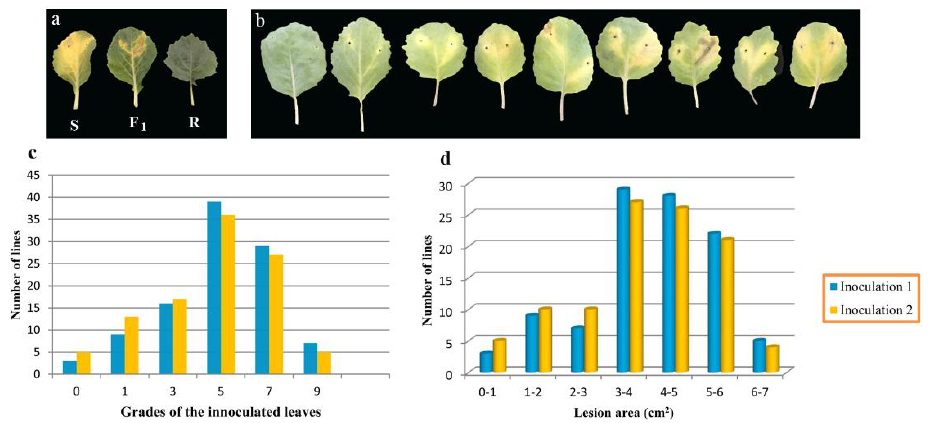
Figure 5. Investigation of symptoms severity to X CC 4 in the F 2 population from Boc3202-4 ( ♀ ) and UNICT5169 ( ♂ ). ( a ) Resistance/sensitivity of F 1 hybrids and their parents to Xcc 4 (S, Boc3202-4. R, UNICT5169). ( b ) Resistance investigation of the F 2 plants. Frequency distribution of Xcc 4 resistance in the F 2 population based on artificial grading ( c ) and PPMS ( d ). Table 3. Investigation of Xcc 4 Resistance of Parents and F 1 Hybrids.